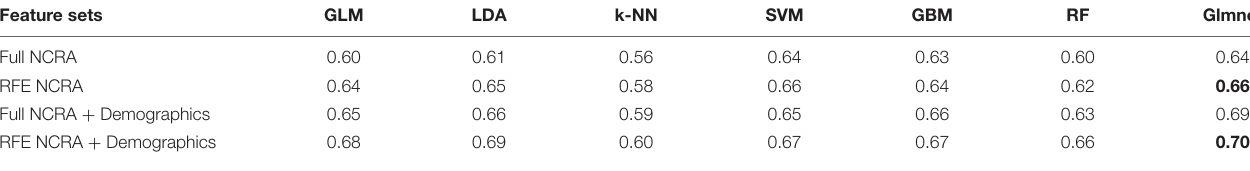
TABLE 8 | ROC curve AUCs by feature sets along with machine learning algorithms used. Feature sets